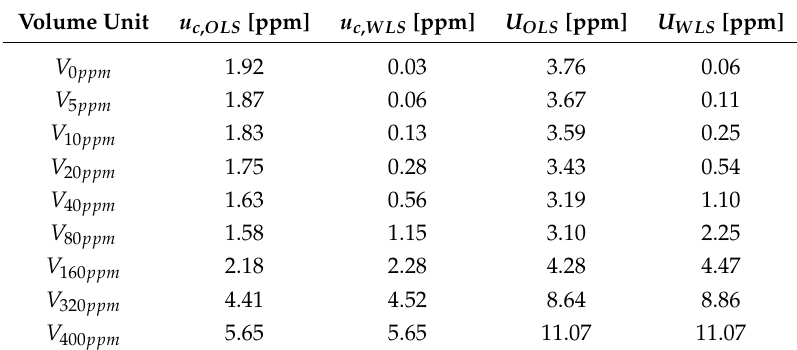
Table 9. Combined and expanded uncertainty for each OiW concentration for both calibration methods: OLS and WLS.